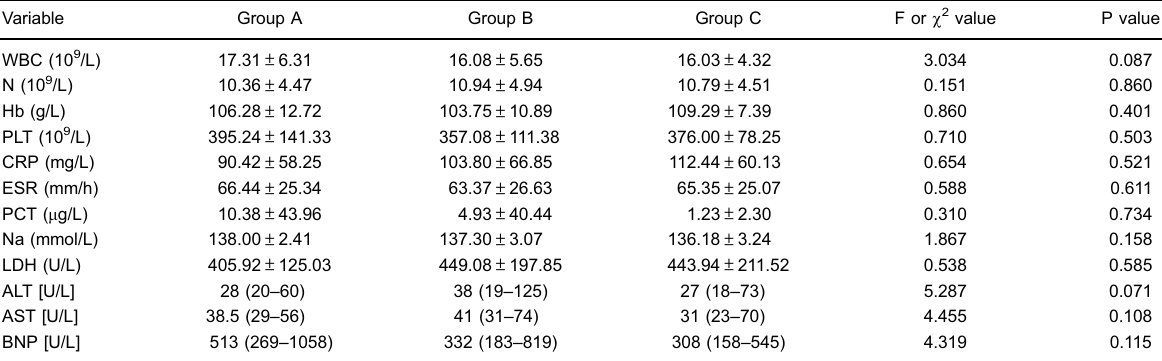
Table 3. Laboratory data of the different Kawasaki disease age groups.